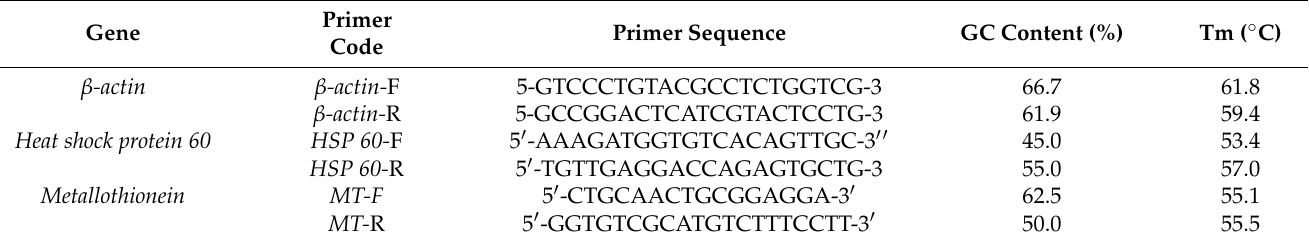
Table 1. List of gene with their primer sequences [37] for the assessment of gene expression.